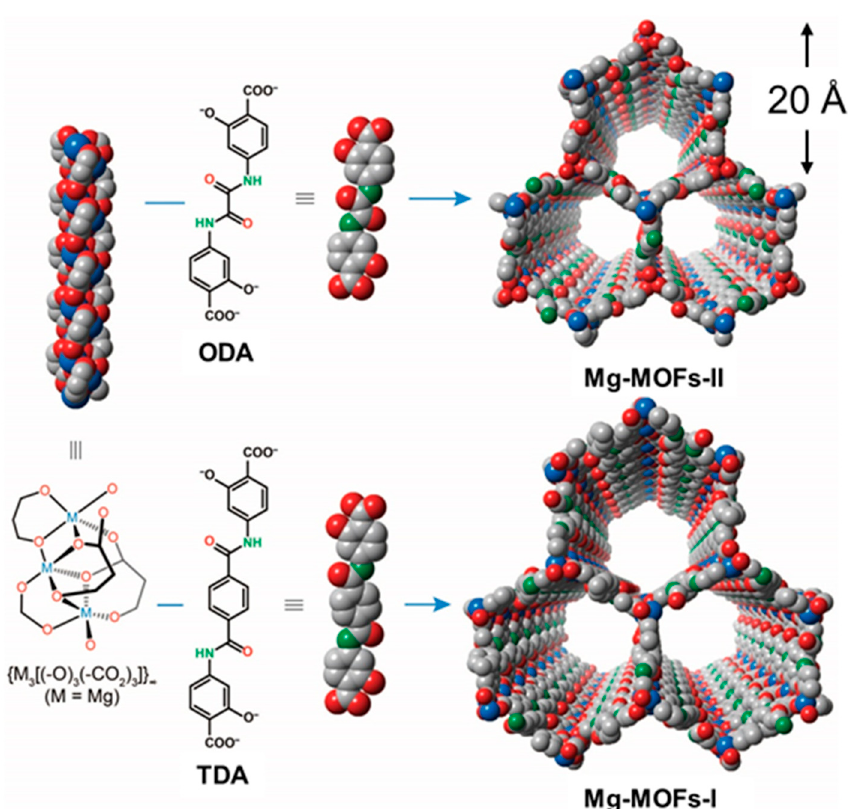
Figure 2. Structures of Mg-MOFs-I and -II. Infinite, rod-shaped metal clusters, {M 3 [(-O) 3 (-CO 2 ) 3 ]} ∞ (where M = Mg), are joined with either TDA 4 − or ODA 4 − linkers to form Mg-MOFs-I and -II, respectively. C, grey; O, red; N, green, H, pink; Mg atoms, blue. H atoms are omitted for simplicity.